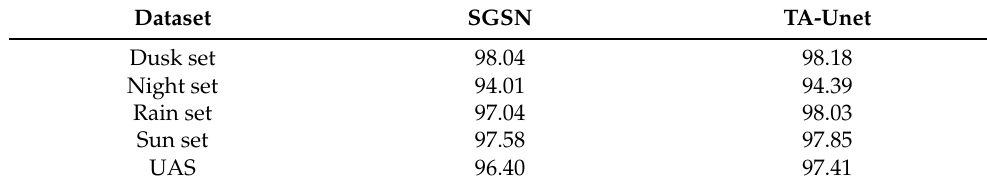
Table 1. The mIoU scores of the proposed TA-Unet and SCGN framework on the UAS dataset. Dataset SGSN Dusk set